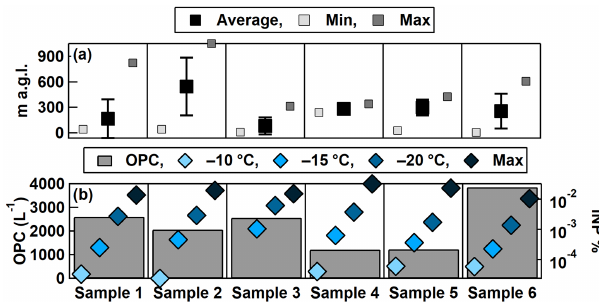
Figure 9. (a) Average, minimum, and maximum altitudes HOVER- CAT flew during each sample collection time period. Error bars rep- resent one standard deviation. (b) The average number concentra- tions of total particles from 380nm to 17µm in diameter measured by the OPC (left axis) and fraction of INPs out of total OPC num- ber at − 10, − 15, and − 20 ◦ C, and the maximum INP concentration measured at the temperature in which the last drop froze (right